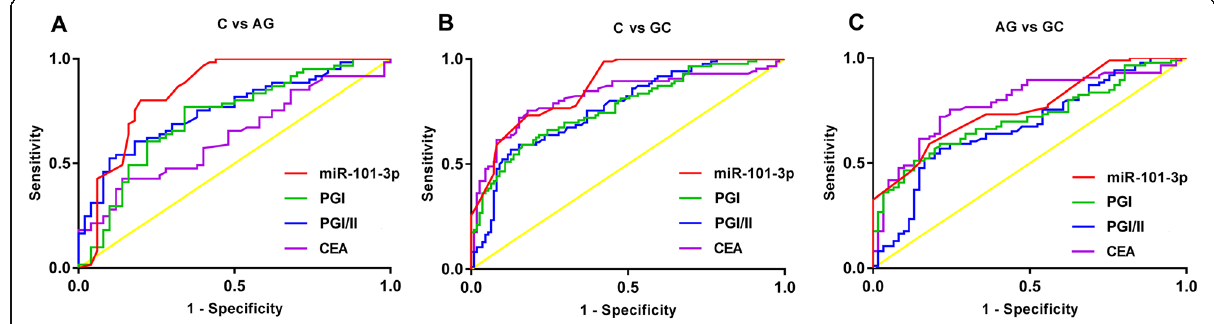
Fig. 1 The diagnostic value of serum miR-101-3p, PGI, and PGI/II alone on AG and GC was analyzed by ROC analysis. a , the ROC curves of serum markers between normal controls (C) and AG patients; b , the ROC curves of serum markers between normal controls (C) and GC patients; c , the ROC curves of serum markers between AG and GC